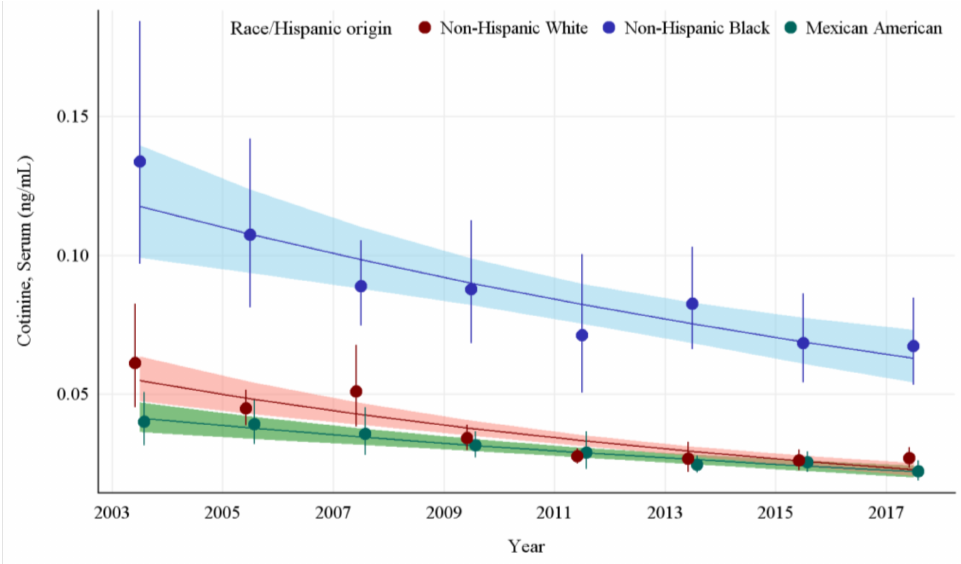
Figure 2. Sample-weighted geometric means (GM) and 95% confidence intervals (CI) of serum cotinine for U.S. nonsmokers aged ≥ 3 years by race and Hispanic origin from 2003 to 2018. The data are plotted at the approximate midpoint of each study interval for eight separate NHANES survey cycles. The points represent the GMs and the vertical lines represent 95% CIs of the GMs for each survey cycle. Data points from different racial groups within the same NHANES survey have been slightly offset to more easily visualize overlapping 95% CIs. The dark trend lines represent the weighted log-linear regression lines for each racial group and the corresponding shaded areas are the 95% CIs of the regression lines.